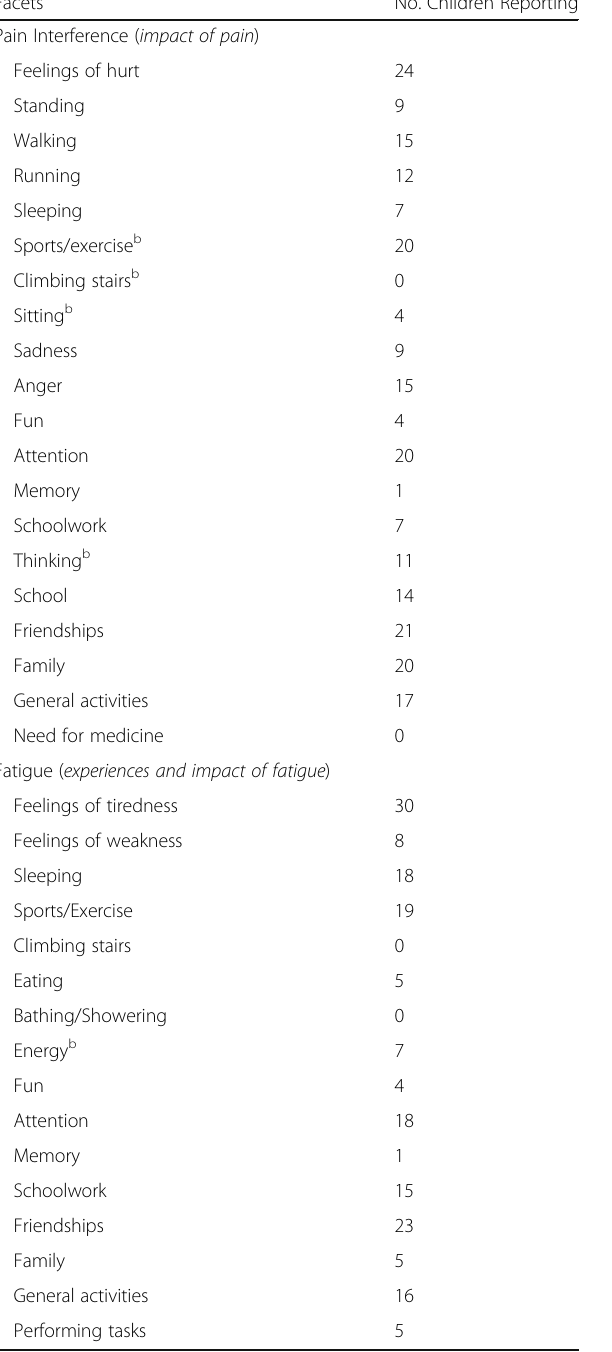
Table 3 Pain Interference and Fatigue conceptual frameworks Table 4 Sleep Disturbance, Sleep-Related Impairment, and and number of children with Crohn ’ s disease for whom each Fatigue conceptual frameworks and number of children with chronic kidney disease for whom each facet was elicited No. Children Reporting